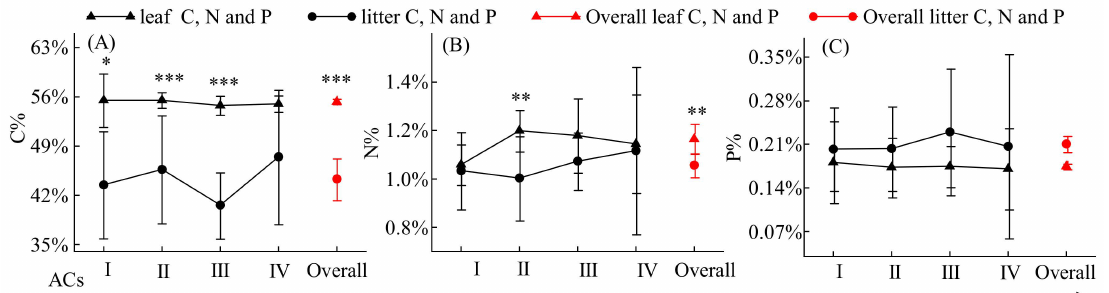
Figure 8. The C ( A ), N ( B ), and P ( C ) content in leaf and litter. The black symbols represent the C, N, and P content at each AC, and the red symbols represent the overall content in leaf and litter. (*, **, and ***) signify content differences between leaf and litter that are significant at 0.05, 0.01, and 0.001 levels,